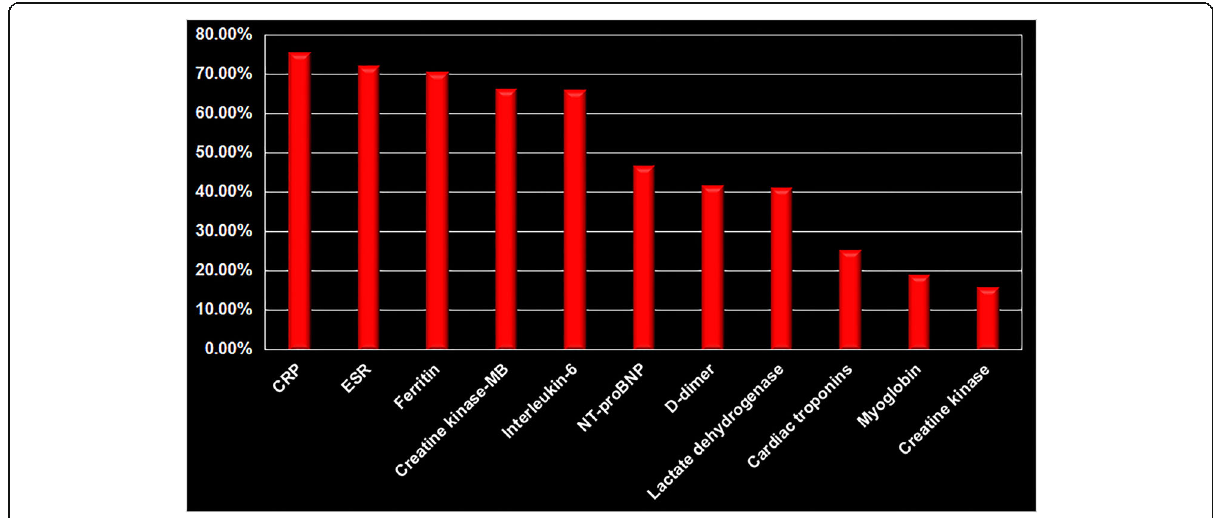
Fig. 2 Pooled frequency of elevated cardiac and inflammatory biomarkers